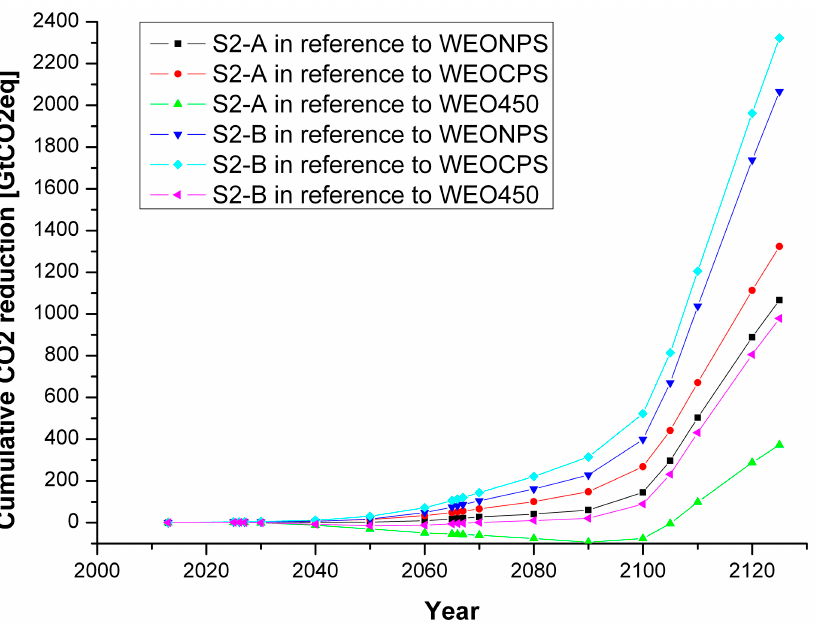
Figure 3. Cumulative CO 2 reduction for scenario S2, sub scenarios A and B, in comparison to World Energy Outlook (WEO) 2015 extrapolation.